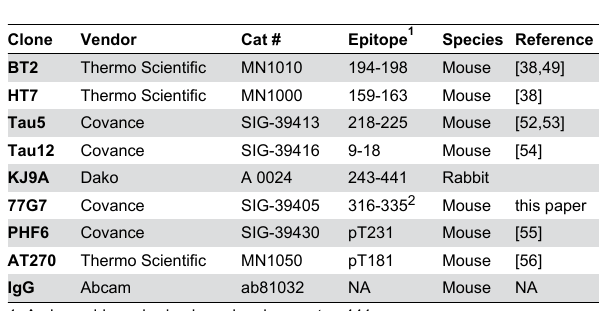
Table 1. Tau and ptau